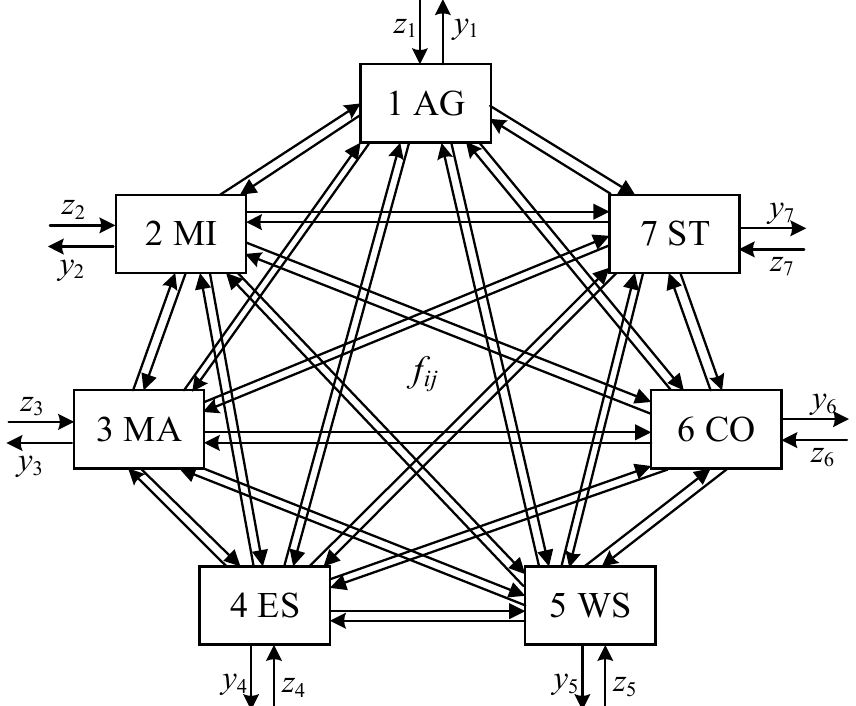
Figure 2. Virtual water network model of Tibet. (Note: AG: agriculture; MI: mining; MA: manufac- turing; ES: energy supply; WS: water supply; CO: construction; ST: services and transport).